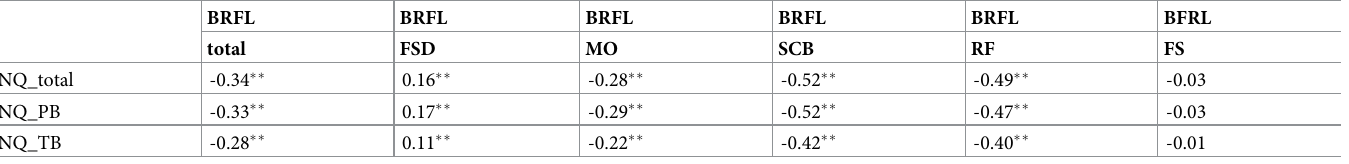
Table 3. Correlation coefficients between INQ with BRFL and its